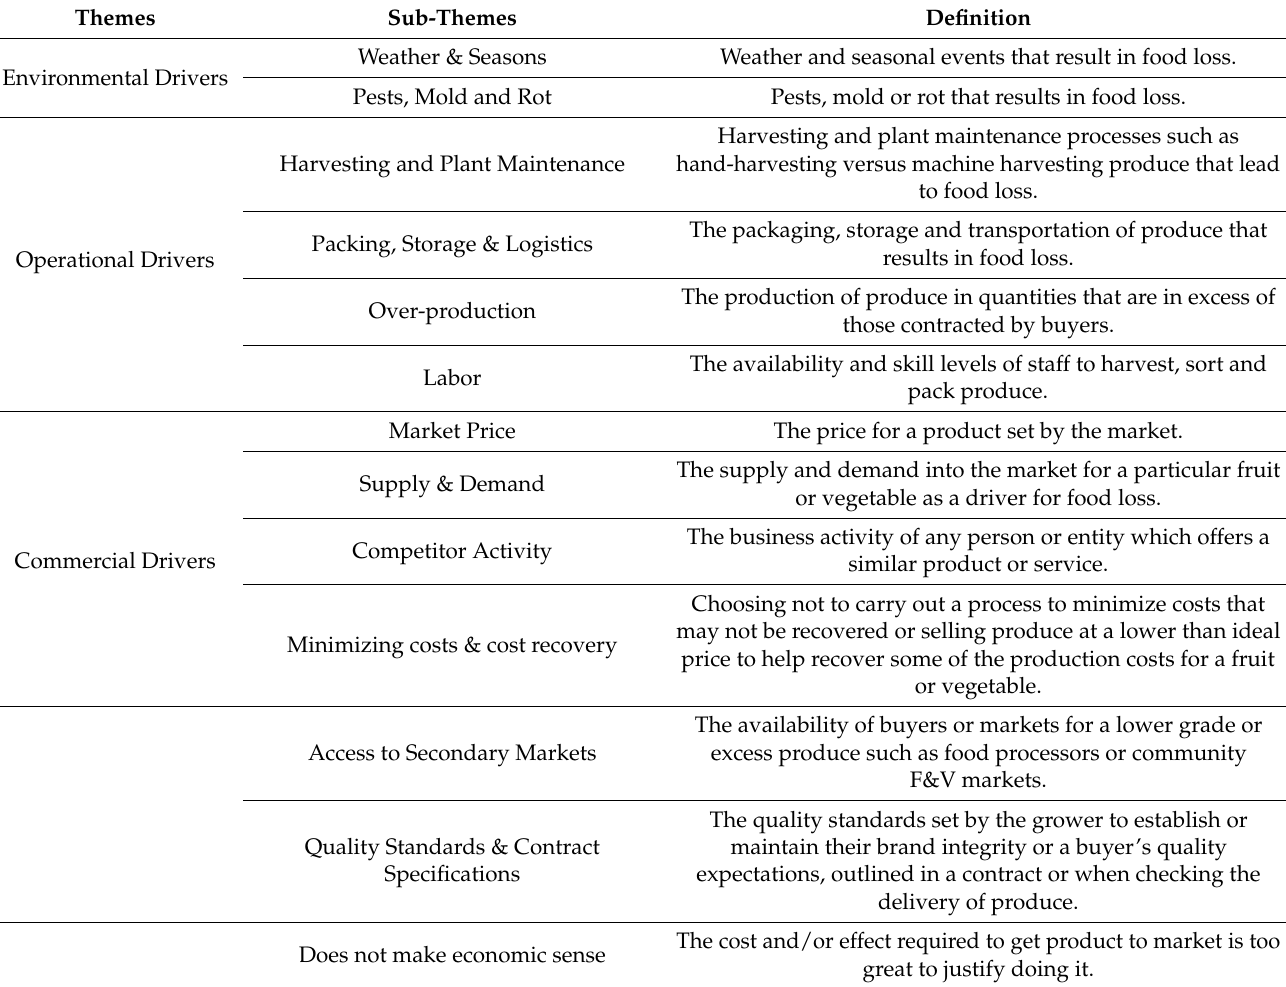
Table 3. A breakdown of the themes, sub-themes from key stakeholder